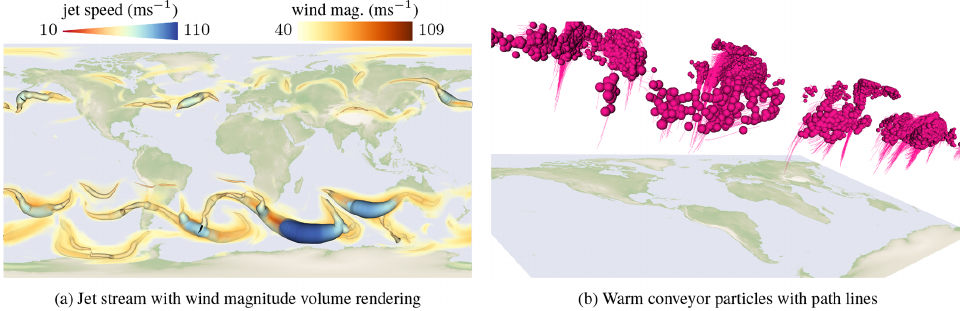
Figure 8. Jet stream core lines are rendered as tubes, with jet speed being mapped to color and radius. (a) With volume rendering of wind speed, (b) warm conveyor belt particles are shown as particles with path lines attached to convey motion.